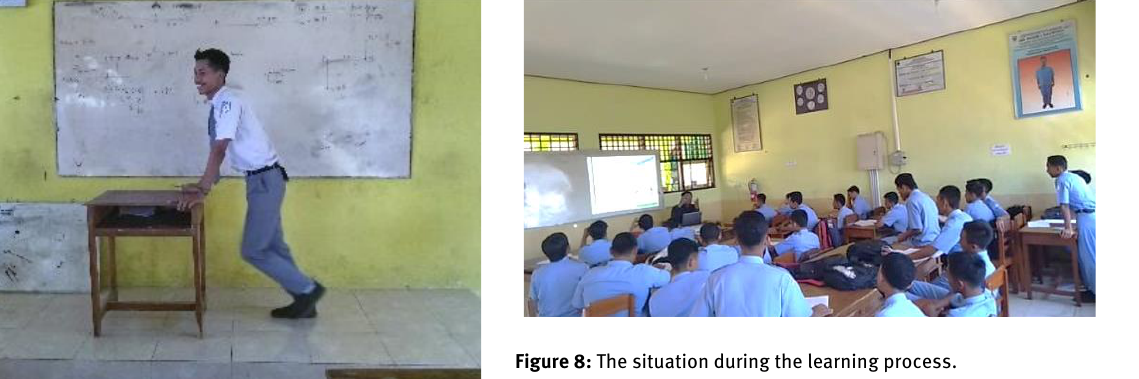
Figure 8: The situation during the learning process.